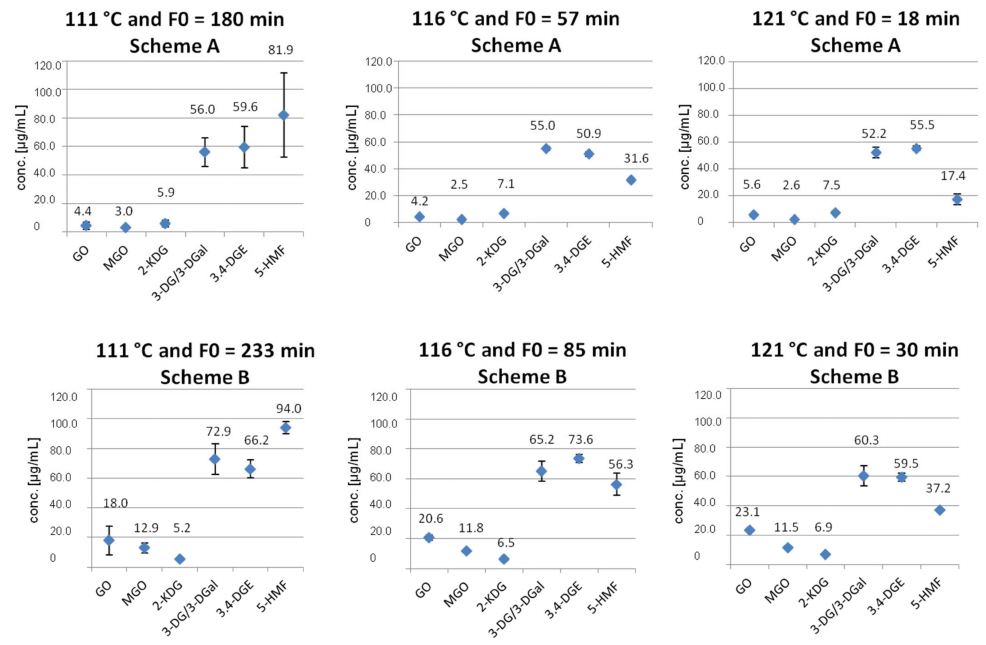
Figure 3. Comparison of the concentrations of GDPs formed at 111–116 ◦ C autoclaved according to scheme A and according to scheme B ( n =